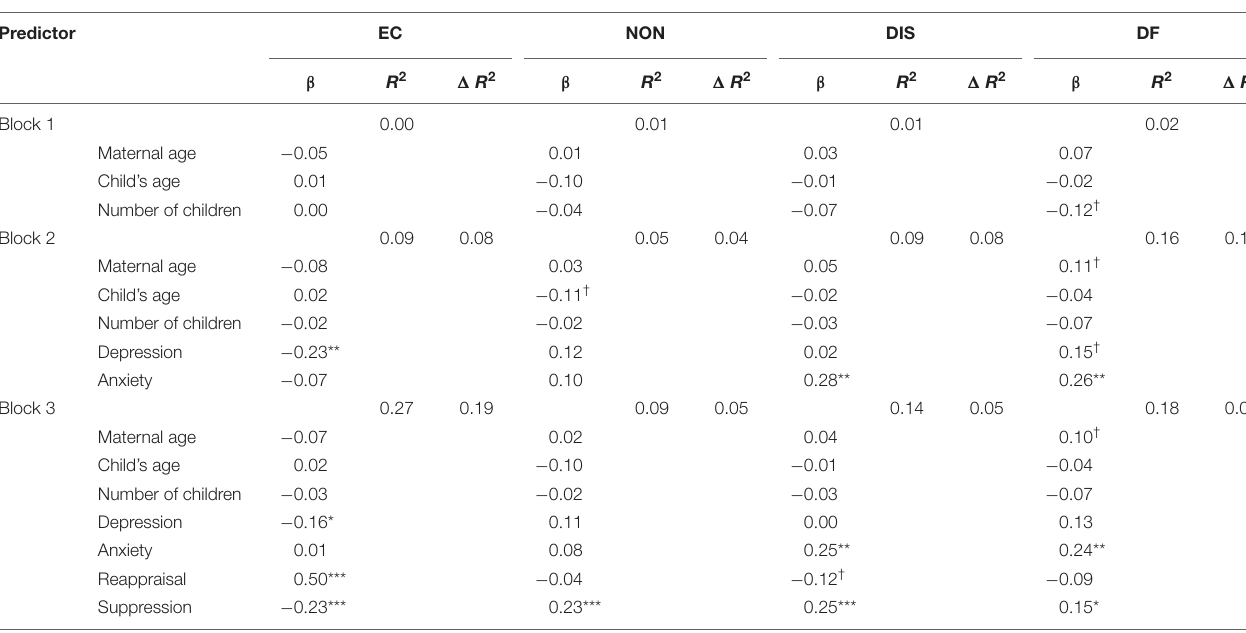
TABLE 2 | Psychopathology and emotion regulation as predictors of ES.